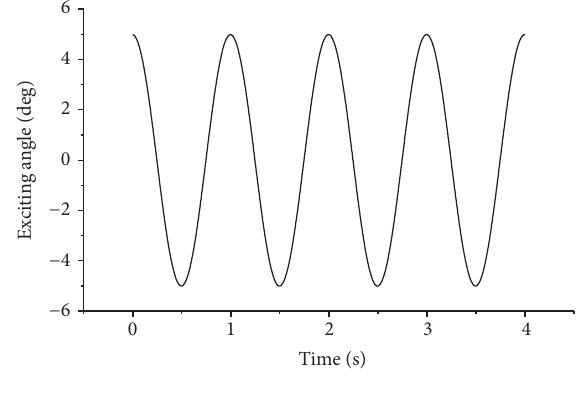
Figure 31: Exciting angle.